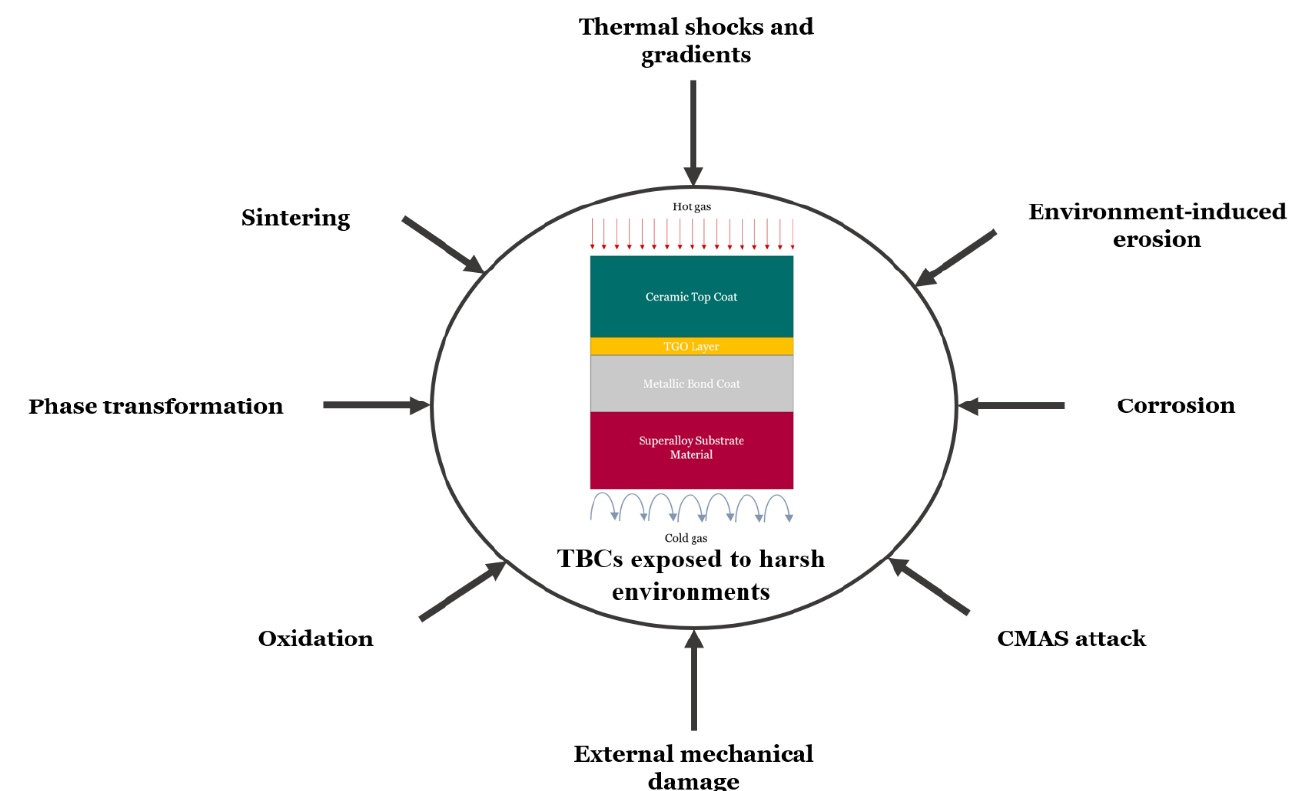
Figure 4. Different damage types that occur to TBCs in hazardous environments.